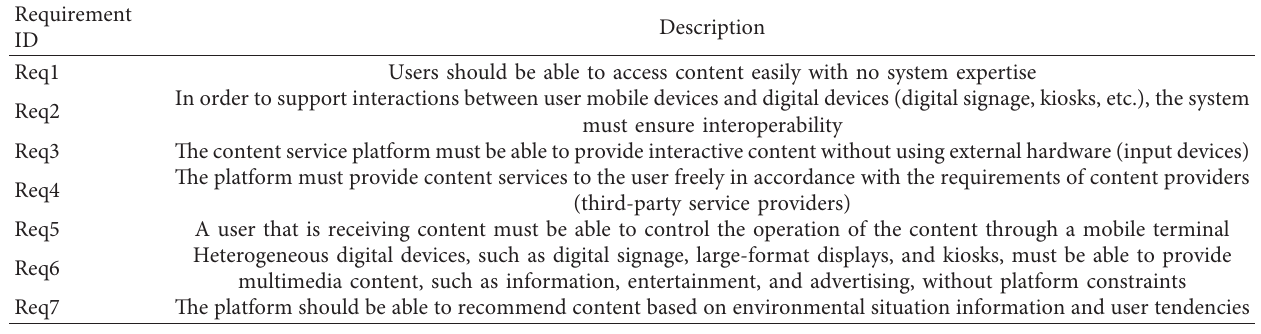
Table 1: Requirements for the content service platform.